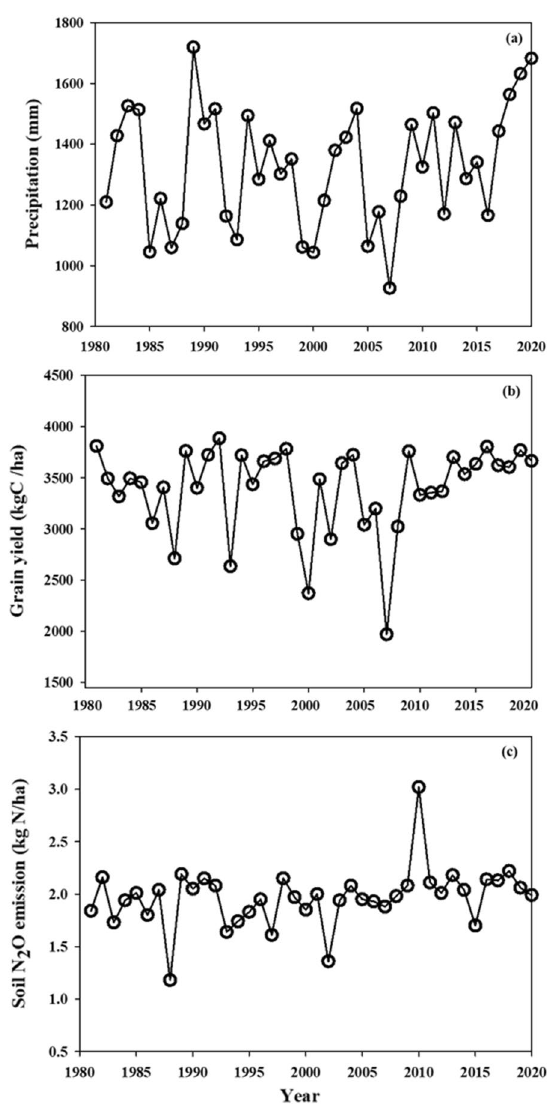
Fig. 2 The variations of precipitation ( a ), simulated corn yield ( b ), and soil N 2 O emission ( c ) from 1981 to 2020 using the long-term precipitation